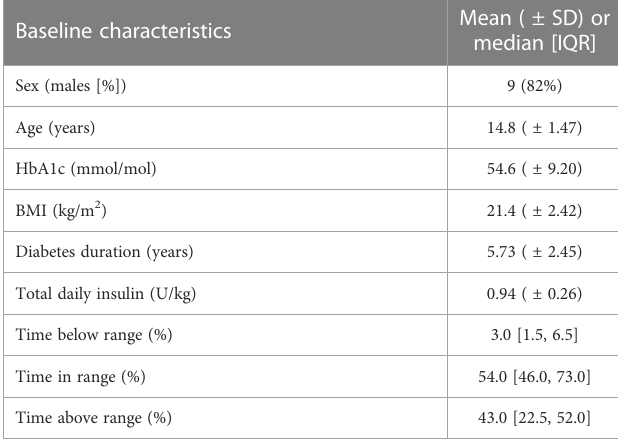
TABLE 1 Baseline characteristics of the 11 participants who completed both study